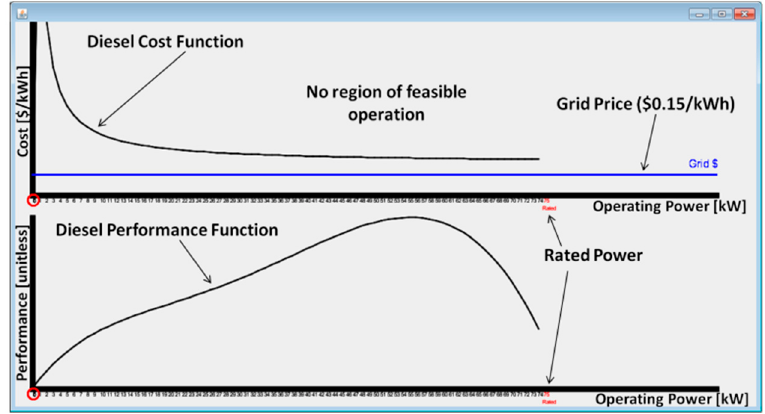
to the grid is between the vertical dashed lines and the vertical solid lines. Decentralized MAS can also work for power management of islanded MGs [18].